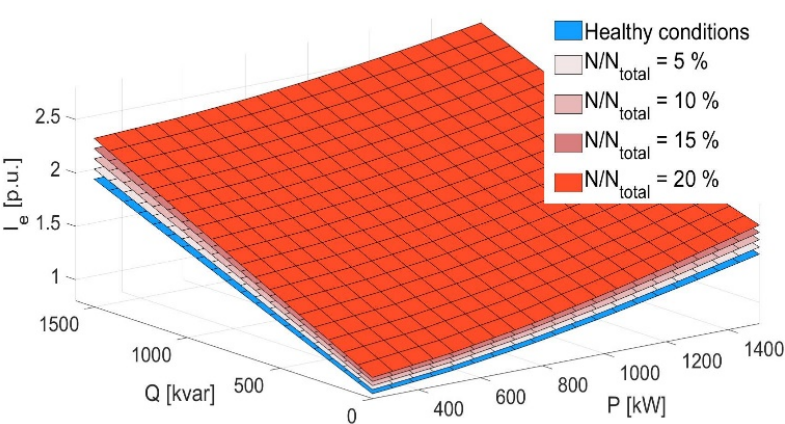
Figure 11. Simulation results. Per-unit exciter field current ( I e ) simulation results for different [P,Q] operating points at reference output voltage ( U = 400 V or 1 p.u. ) in faulty conditions (interturn faults at the field winding of the main machine, with different severity levels: N/N total = 5, 10, 15 and 20% ).